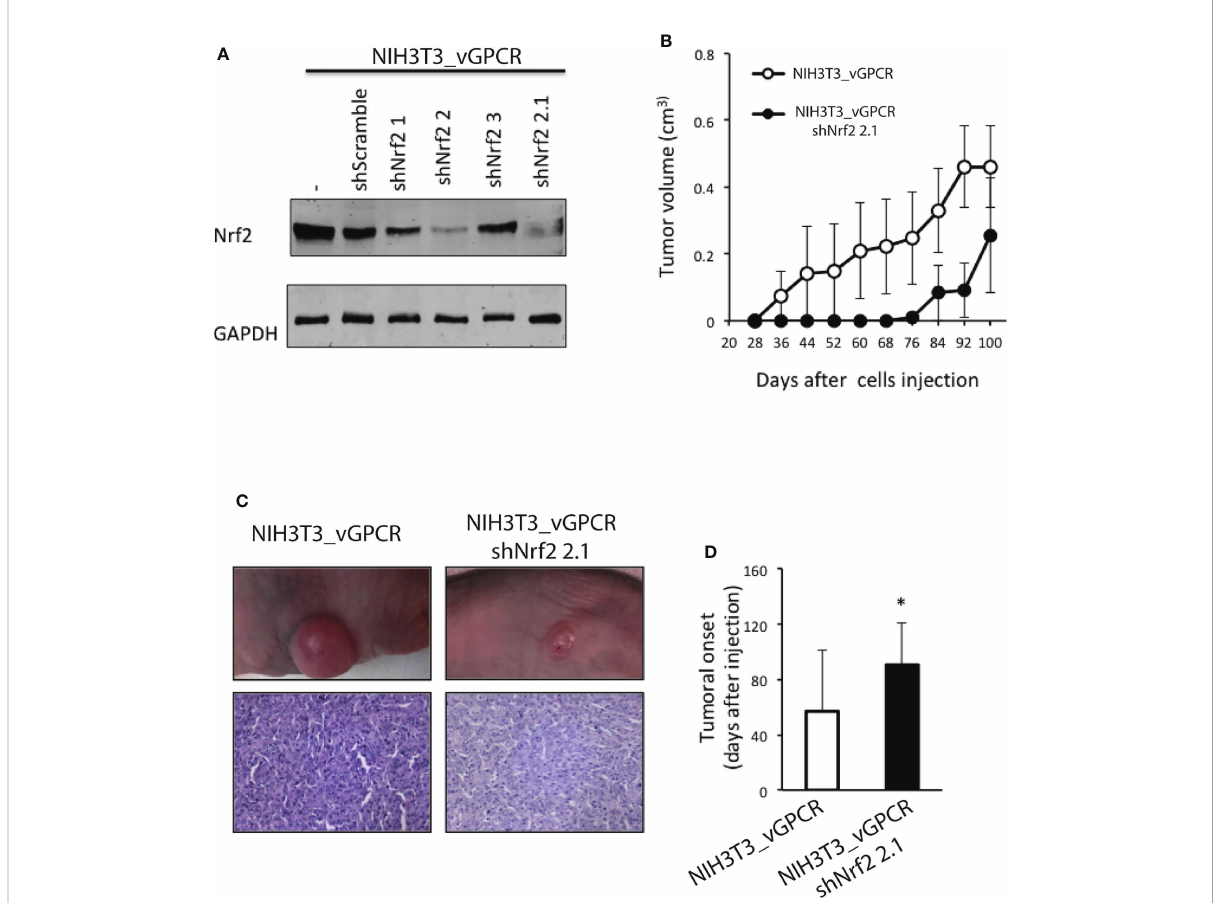
FIGURE 7 (A) Western Blot Assays performed in NIH3T3_vGPCR or different NIH3T3_vGPCR stable cell lines for the expression of shRNAs targeting Nrf2. We used an anti-Nrf2 antibody to detect Nrf2 levels in the different cell lines. (B) 1 X 10 6 NIH3T3_vGPCR (control) or NIH3T3_vGPCR_shNrf2 2.1 cells were injected subcutaneously in the right fl ank of six and fi ve nude mice respectively. Data are mean ± S.E.M expressed as tumor volume (cm 3 ), calculated as Materials and Methods described. (Two-way repeated measures ANOVA, treatment factor F 1, 81 = 2.47 p = 0.15). (C) An example of tumor-bearing mice from each group is depicted. H&E staining from representative tumors from mice injected with NIH3T3_vGPCR or NIH3T3_vGPCR_shNrf2 cells, respectively. (D) The tumor onset was de fi ned as the fi rst day of appearance of a measurable tumor. Data